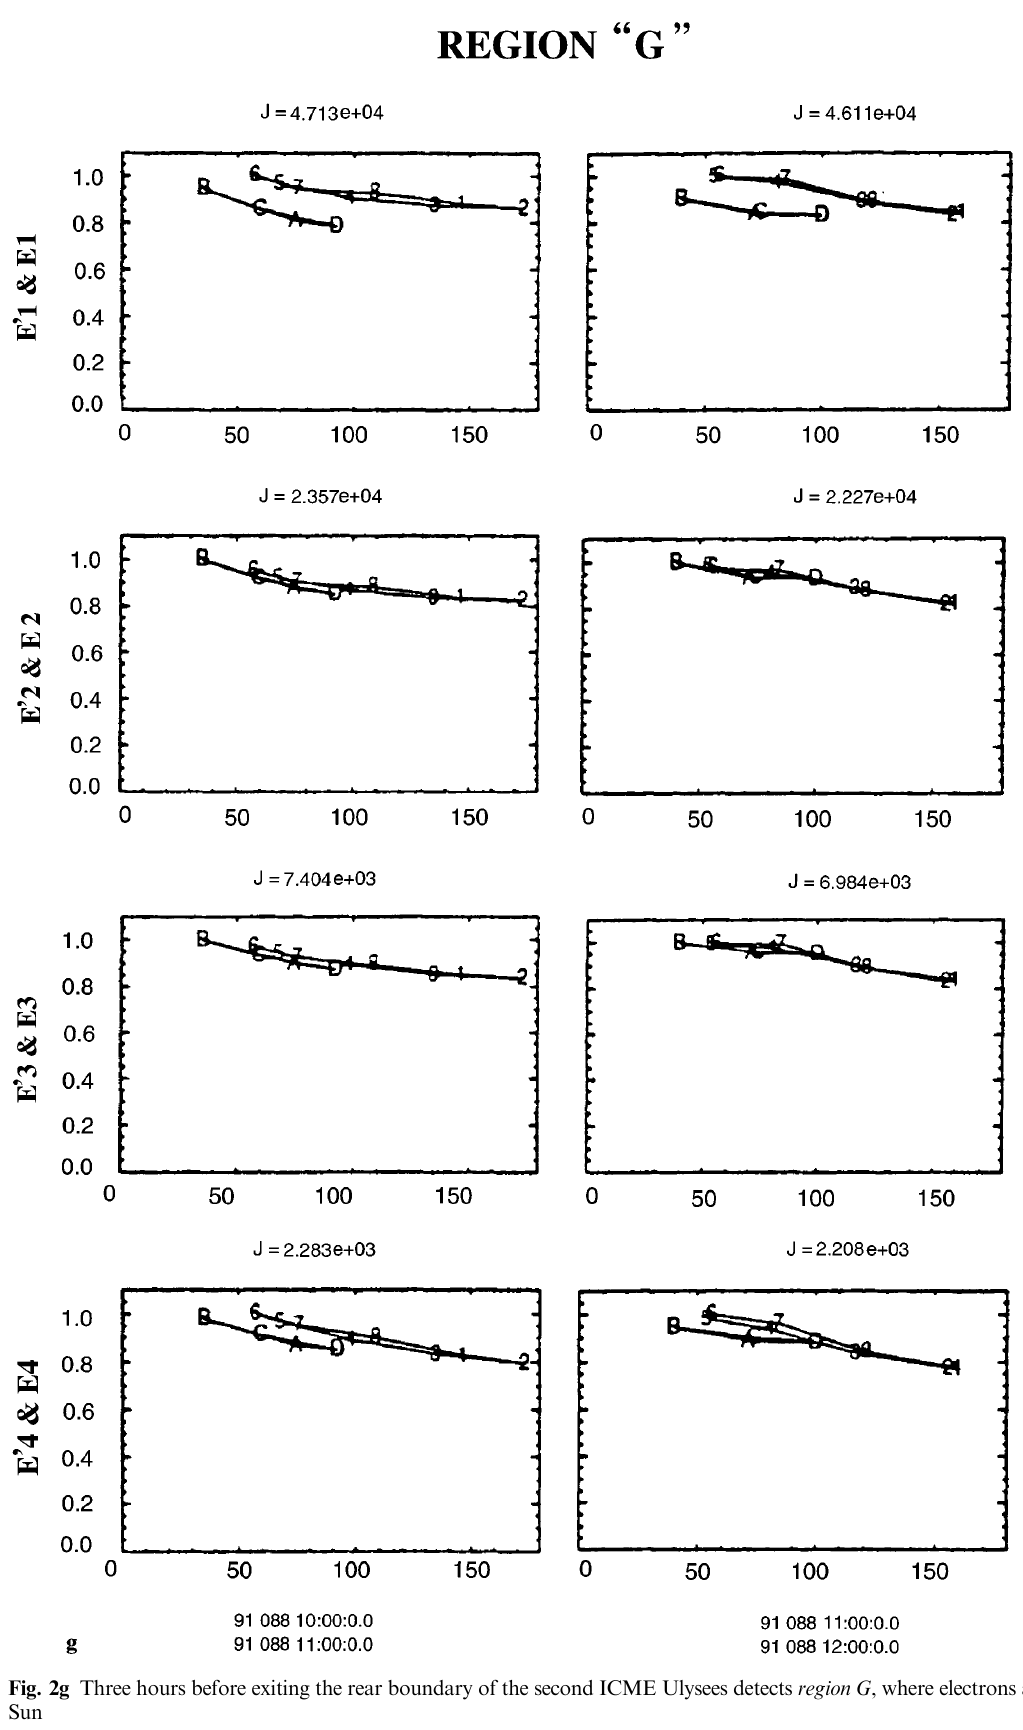
Fig. 2g Three hours before exiting the rear boundary of the second ICME Ulysees detects region G , where electrons are streaming away from the